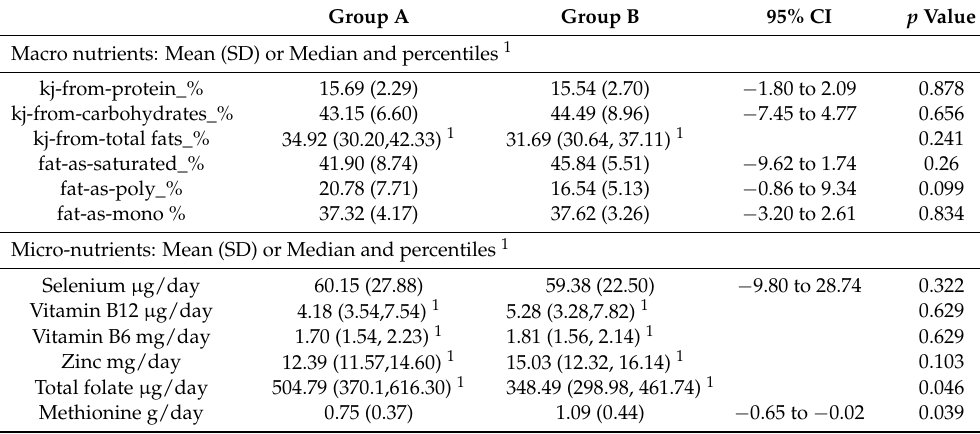
Table 2. Dietary intake recorded for subgroups A and